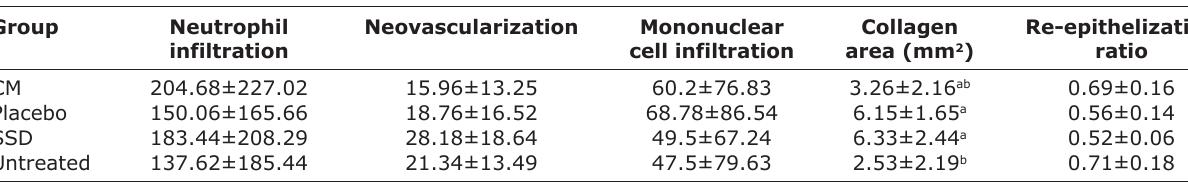
Table-5: Histology parameters day 21. Group